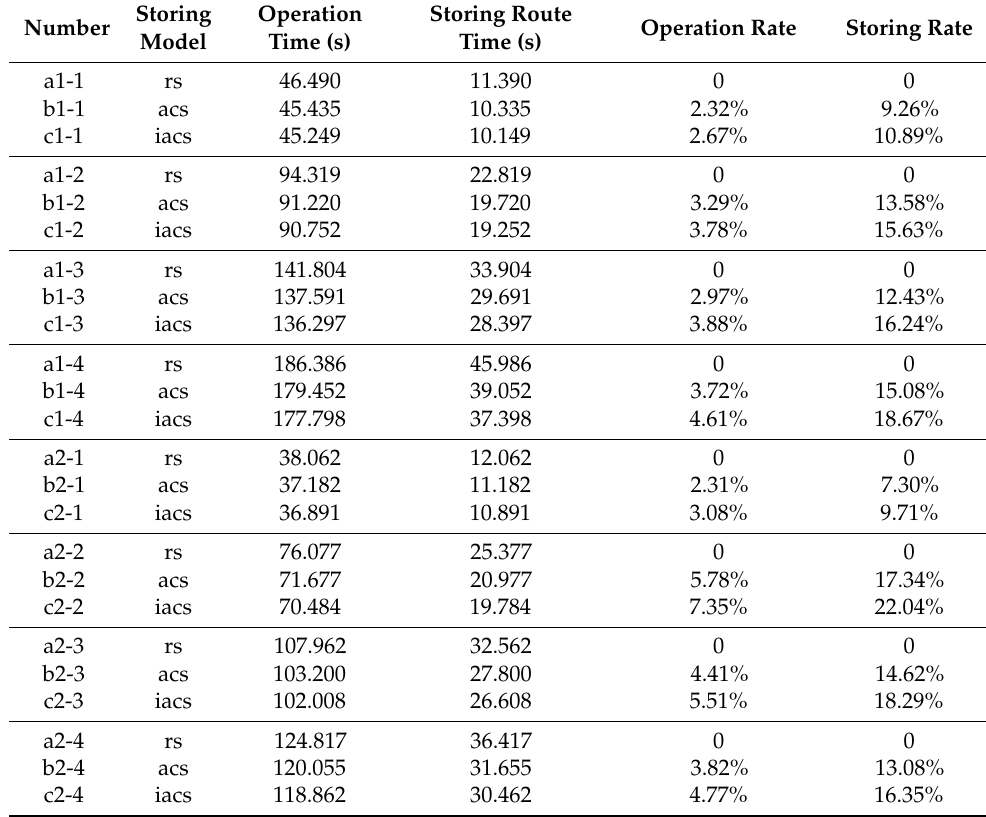
Table 7. Operation test results of different storing